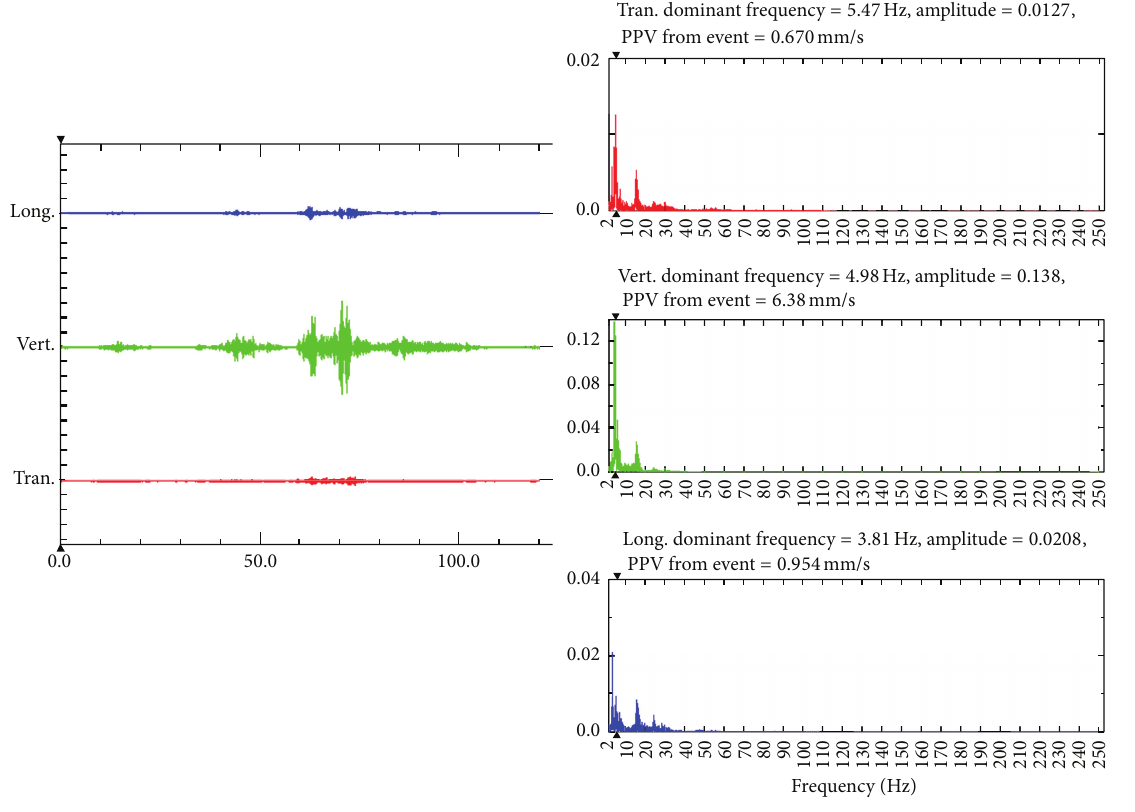
Figure 5: Measurement on base station 6R (middle of the span).